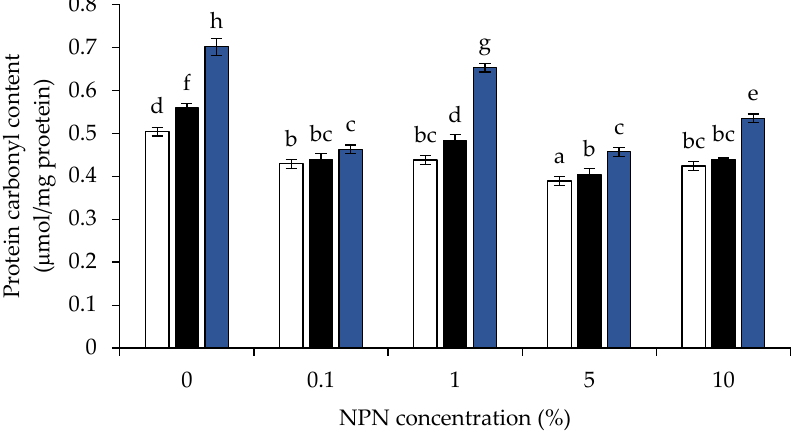
Figure 5. Changes in the protein carbonyl content of oxymyoglobin model system added with 0, 0.1, 1, 5, and 10% ( v / v ) of stingray non-protein nitrogen (NPN) incubated at 4 ◦ C (white), 25 ◦ C (black), and 60 ◦ C (blue) for 120 min. The initial carbonyl content for all treatments was 0.324 µ mol/mg protein. Bars represent standard deviation from triplicate determinations. Different letters (a–h) indicate significant differences ( p < 0.05).